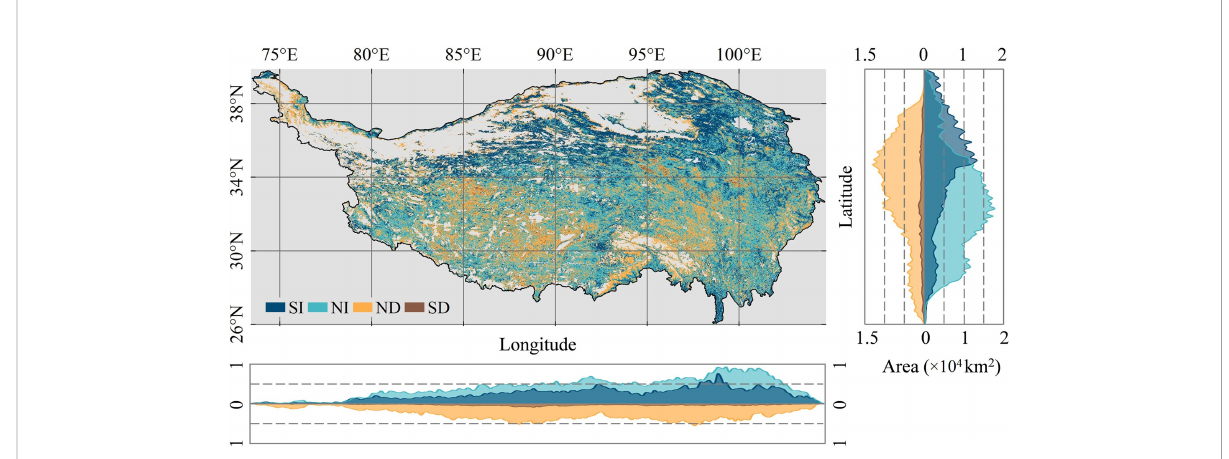
FIGURE 3 Vegetation greenness changes along longitude and latitude gradients on the Qinghai-Tibetan